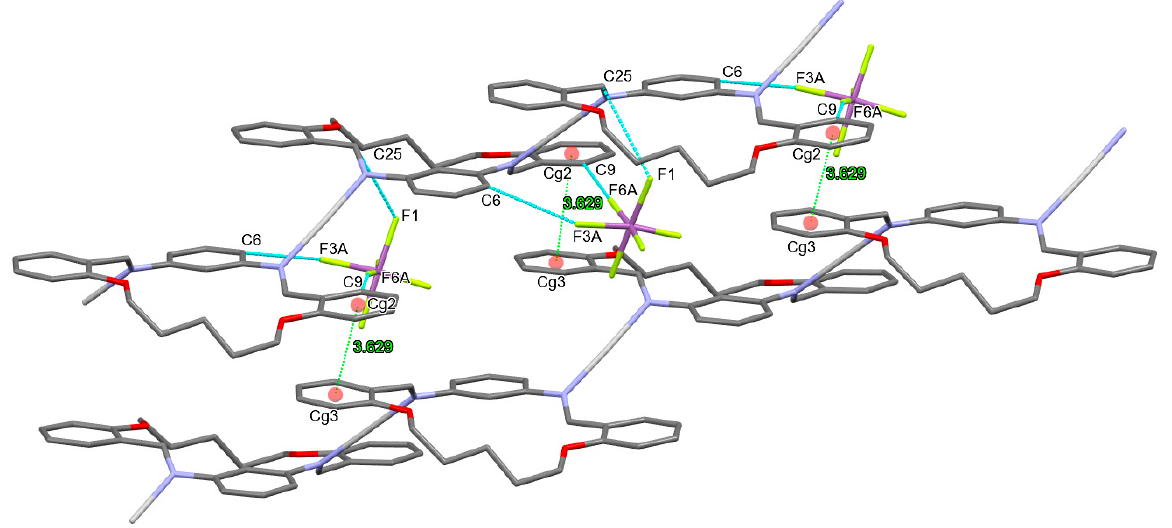
Figure 6. Representation of crystal packing in AgLSbF 6 . O–H ··· F interactions between SbF 6 anions and ligand molecules are represented by blue dashed lines. π ··· π interactions are represented by blue dashed lines. Hydrogen atoms are omitted for